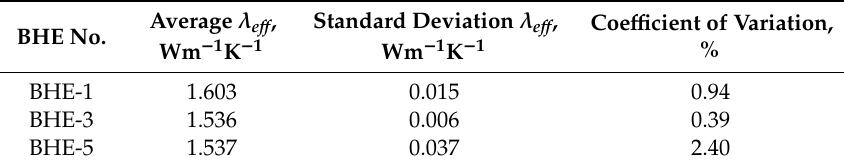
Table 4. Statistics of e ff ective thermal conductivity λ e ff values in BHEs.